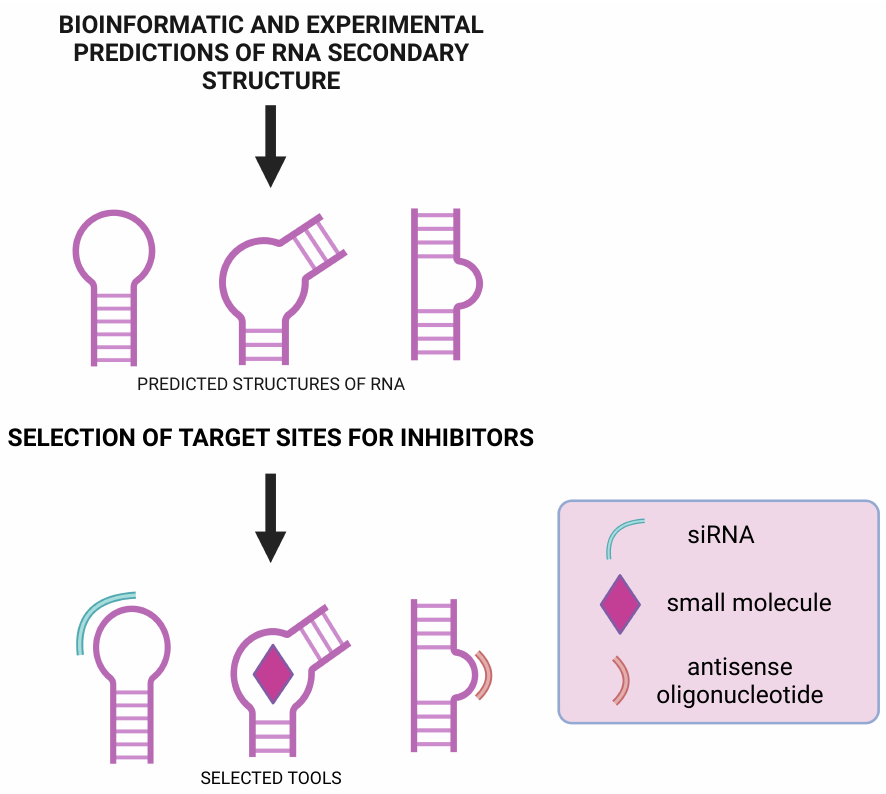
Figure 3. Scheme of the selection strategy of targeting sites of SARS-CoV-2 and influenza A virus RNA and choice of inhibition